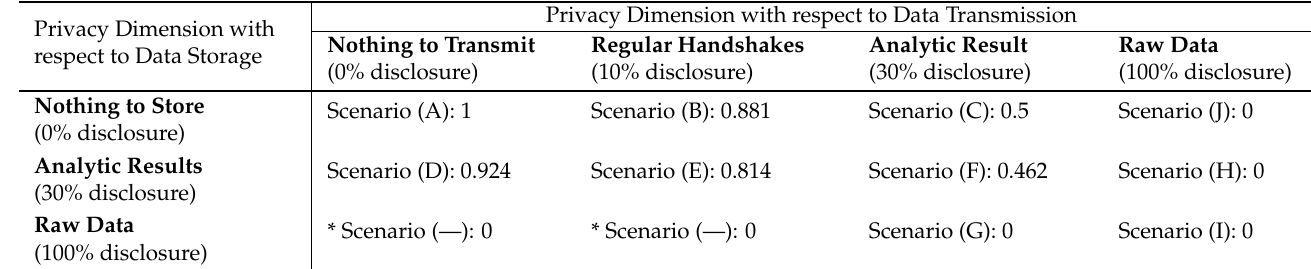
Table 4. Quantified Privacy in Different Scenarios of Daily Activity